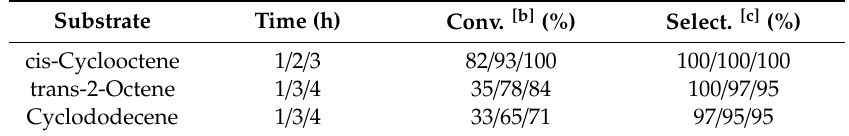
Table 3. Olefin epoxidation with TBHP, in the presence of 1 [a]